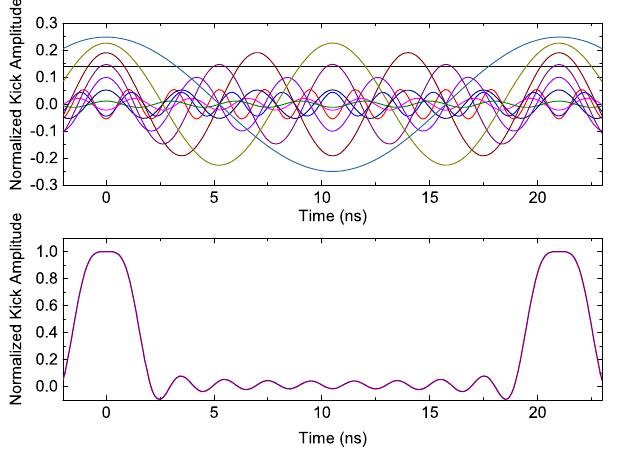
FIG. 2. Normalized continuous kicker waveform of 47.63 MHz repetition rate (bottom) resultingfrom the summationofa DCoffset and 10 harmonics of the base frequency of 47.63 MHz (top).